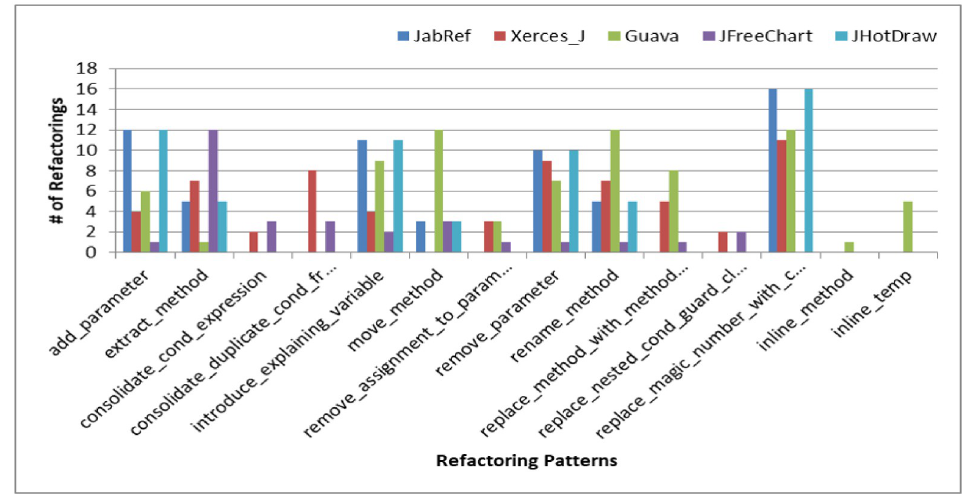
Fig 8. Refactoring patterns in removed